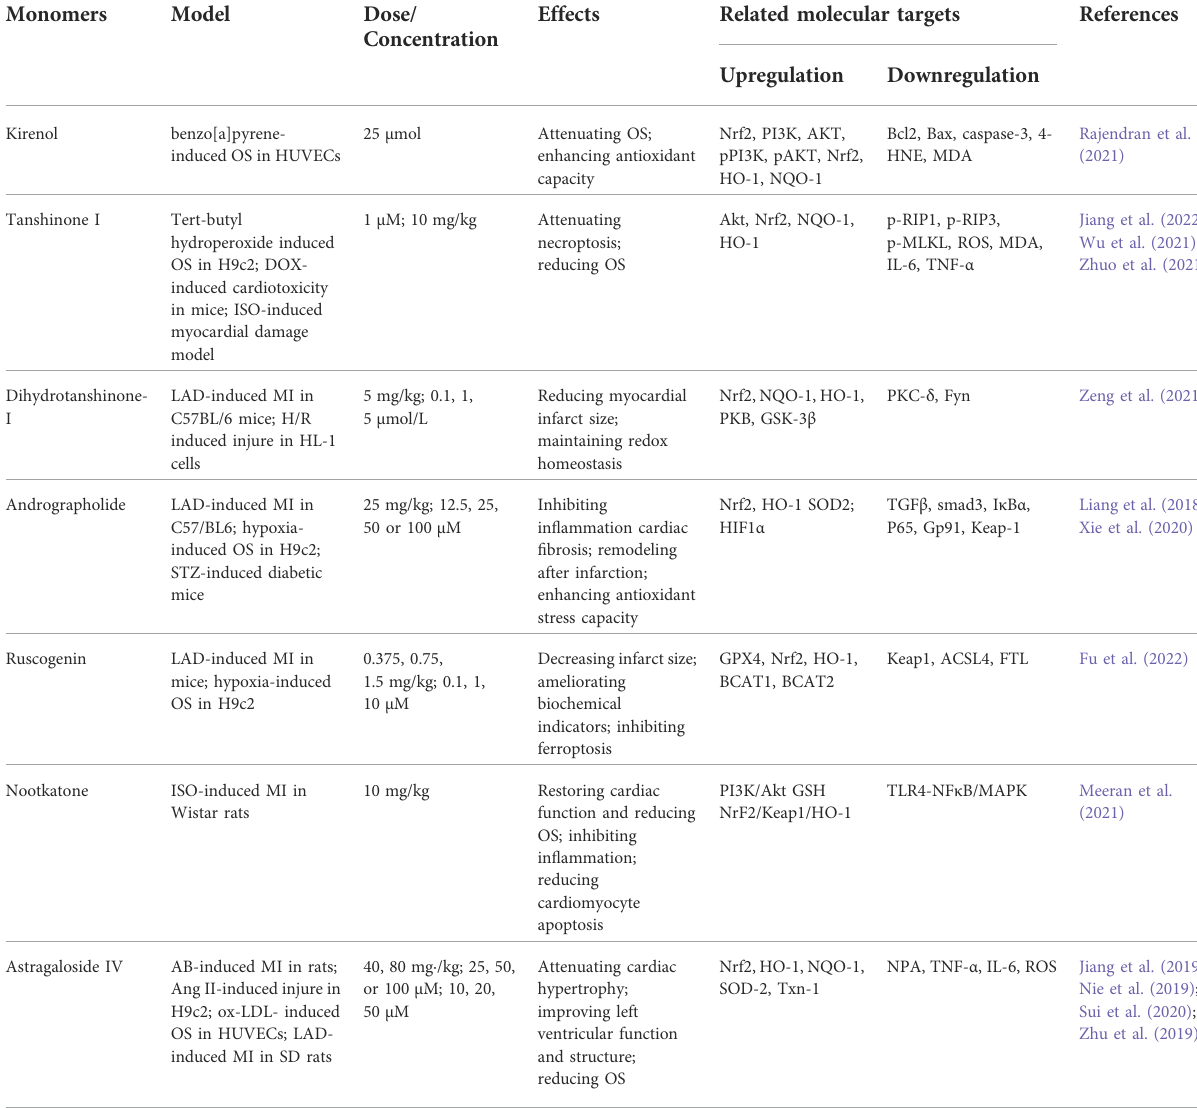
TABLE 3 Protective effects of terpenoids on vascular endothelial